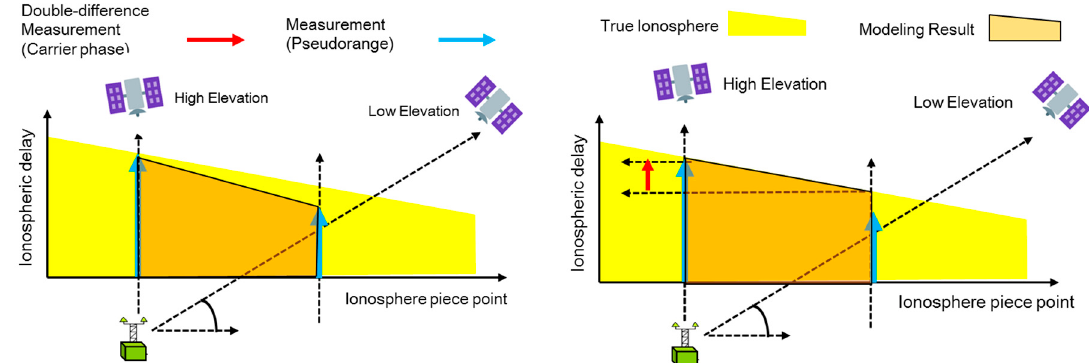
Figure 1. Ionospheric modeling example using ( a ) pseudorange only and ( b ) pseudorange and double-difference carrier phase.